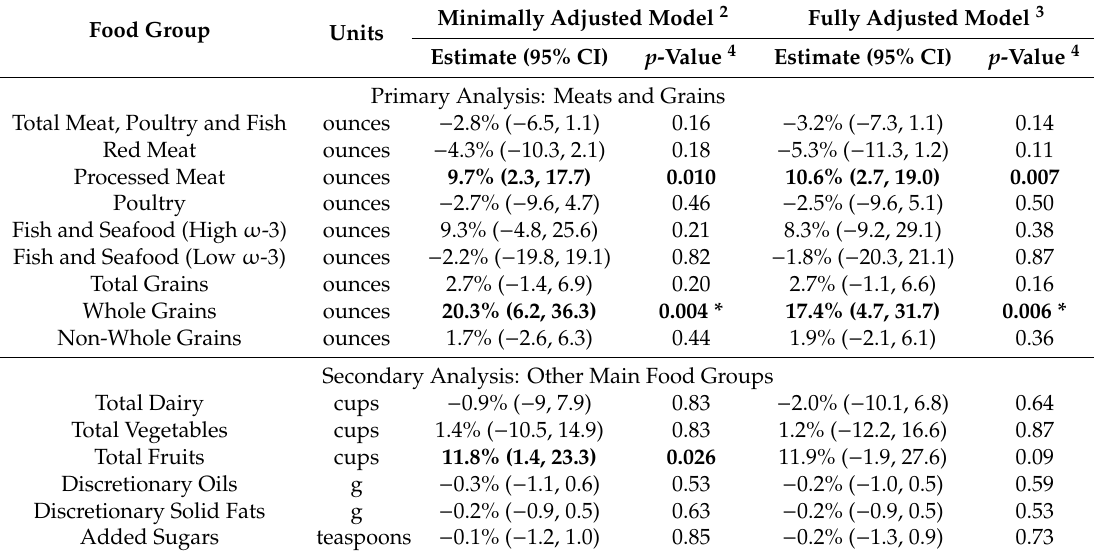
Table 2. Expected change in creatinine-adjusted melamine concentration per one-unit increase in consumption of each food group (with 95% confidence intervals (CIs)) 1